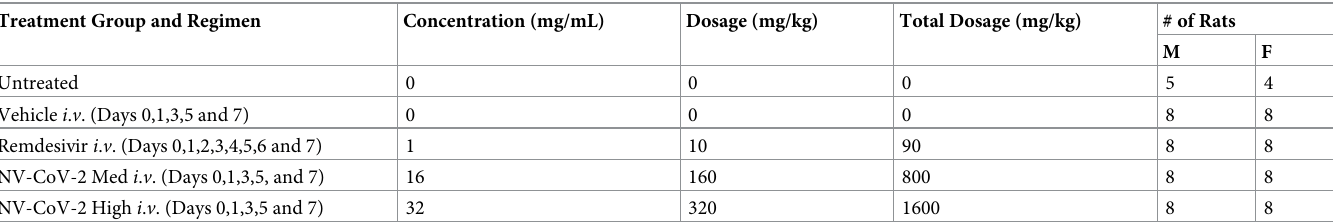
Table 1. Treatment groups and regimen. Treatment Group and